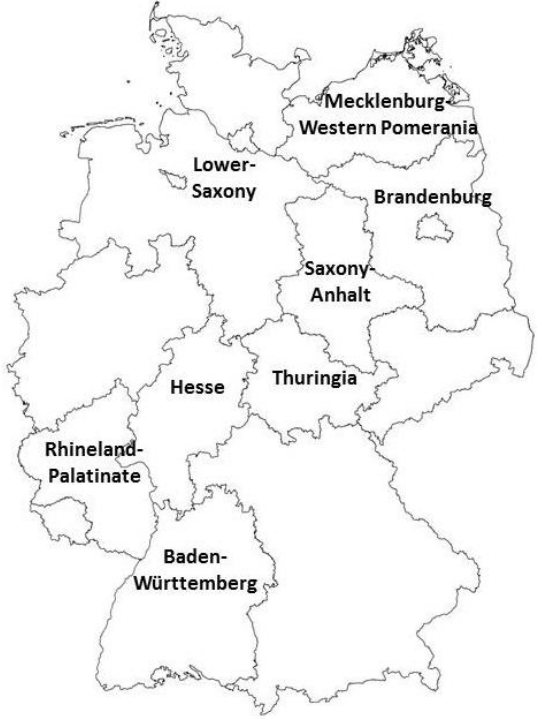
Figure 1. Origin of the German horse sera samples (from eight different federal